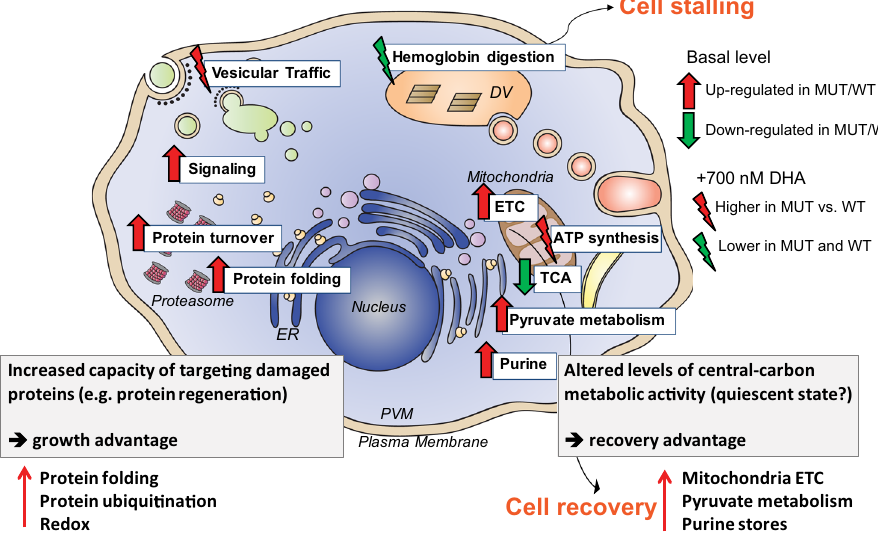
Fig. 6 Proposed model for the role of K13 in ART resistance. K13 mutations are associated with an up-regulation of protein folding as well as proteasome- linked protein turnover that may provide a growth advantage via a greater capacity of the mutant parasite to target and eliminate damaged proteins caused by the proteotoxic ART drug. K13 also appears to be involved in other novel pathways including intracellular signaling, pyruvate metabolism, purine salvage, and the mitochondrial electron transport chain (ETC). These functions suggest an altered central carbon metabolism and represent a quiescent state maintained by the parasite that allows for a recovery advantage following DHA exposure. DHA inhibits hemoglobin uptake or degradation and induces stalling in both K13 mutant (MUT) and wild-type (WT) rings. Recovery in K13 mutants may occur through enhanced mitochondrial ATP metabolic function and remodeling of the parasite ’ s secretory and vesicular transport processes. Inhibition of mitochondrial ETC activity lowers the survival of K13 mutant parasites to DHA